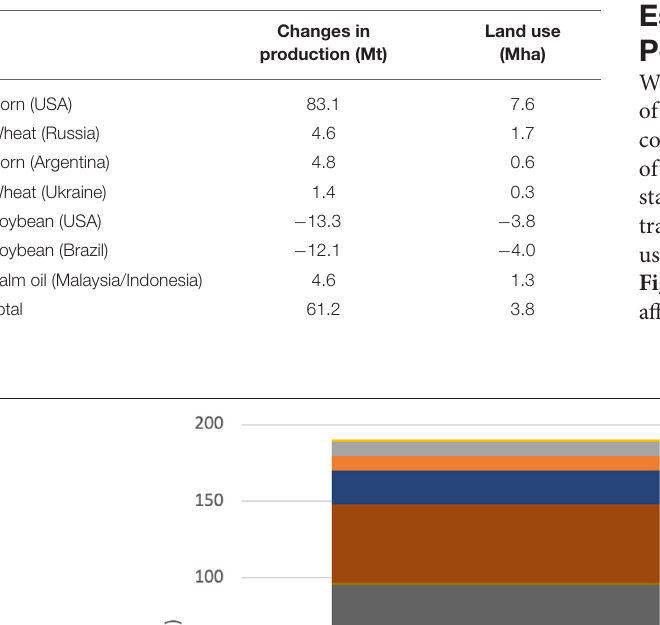
TABLE 1 | Implications on crop production and land use associated with the policy shock of 15 billion gallons of ethanol, including the balancing of markets (food, feed, vegetable oil, and exports).